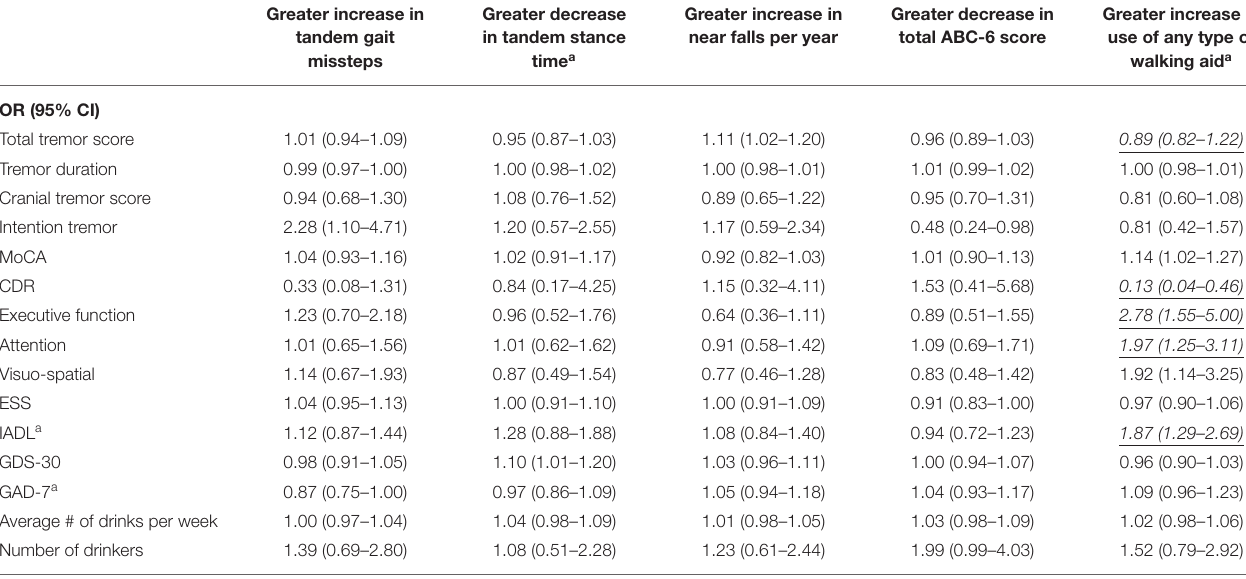
TABLE 3B | Unadjusted logistic regression models: Baseline characteristics as predictors of change in gait and balance outcomes.